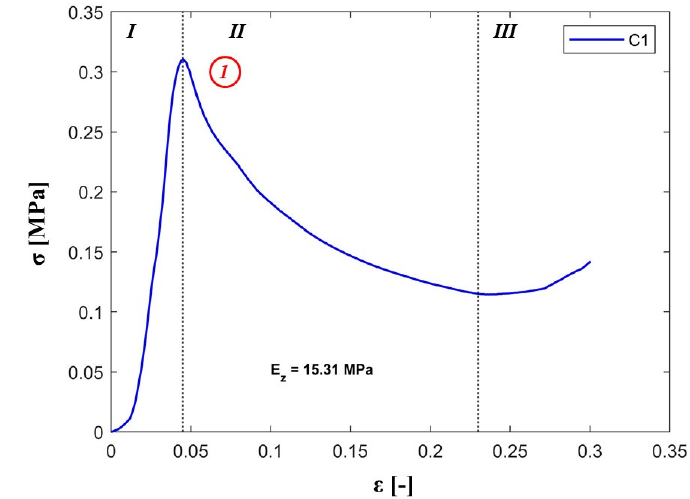
Figure 10. Stress-strain flow and characteristics of the investigated pyramidal cellular structure.